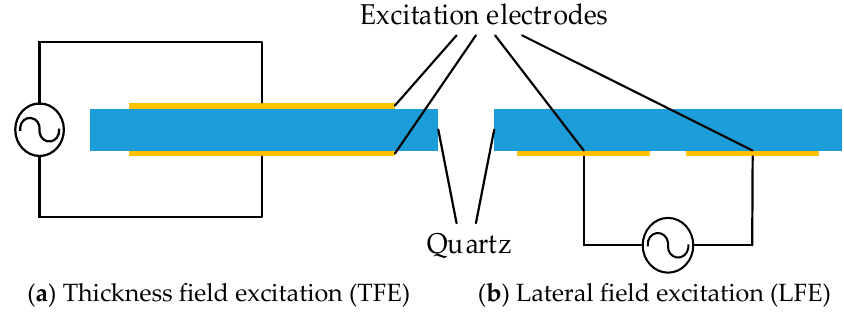
Figure 1. Two kinds of QCM with different structures .